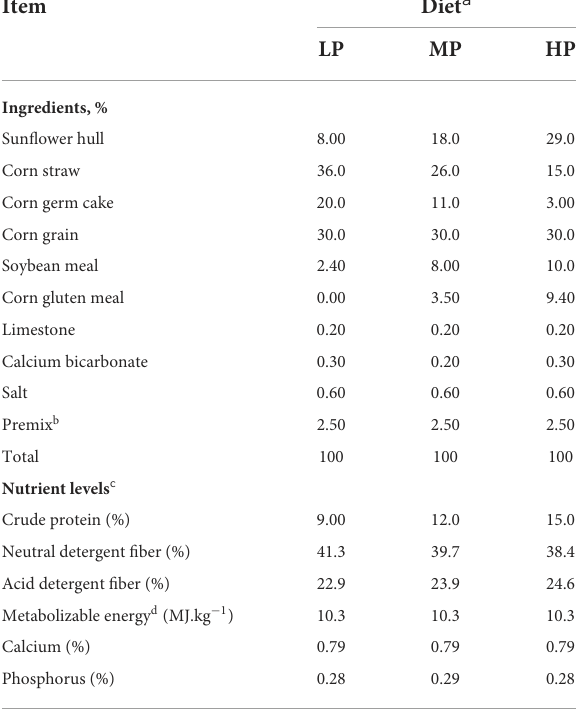
TABLE 1 Ingredients and nutrient levels of the experimental diets with three different protein levels (dry matter